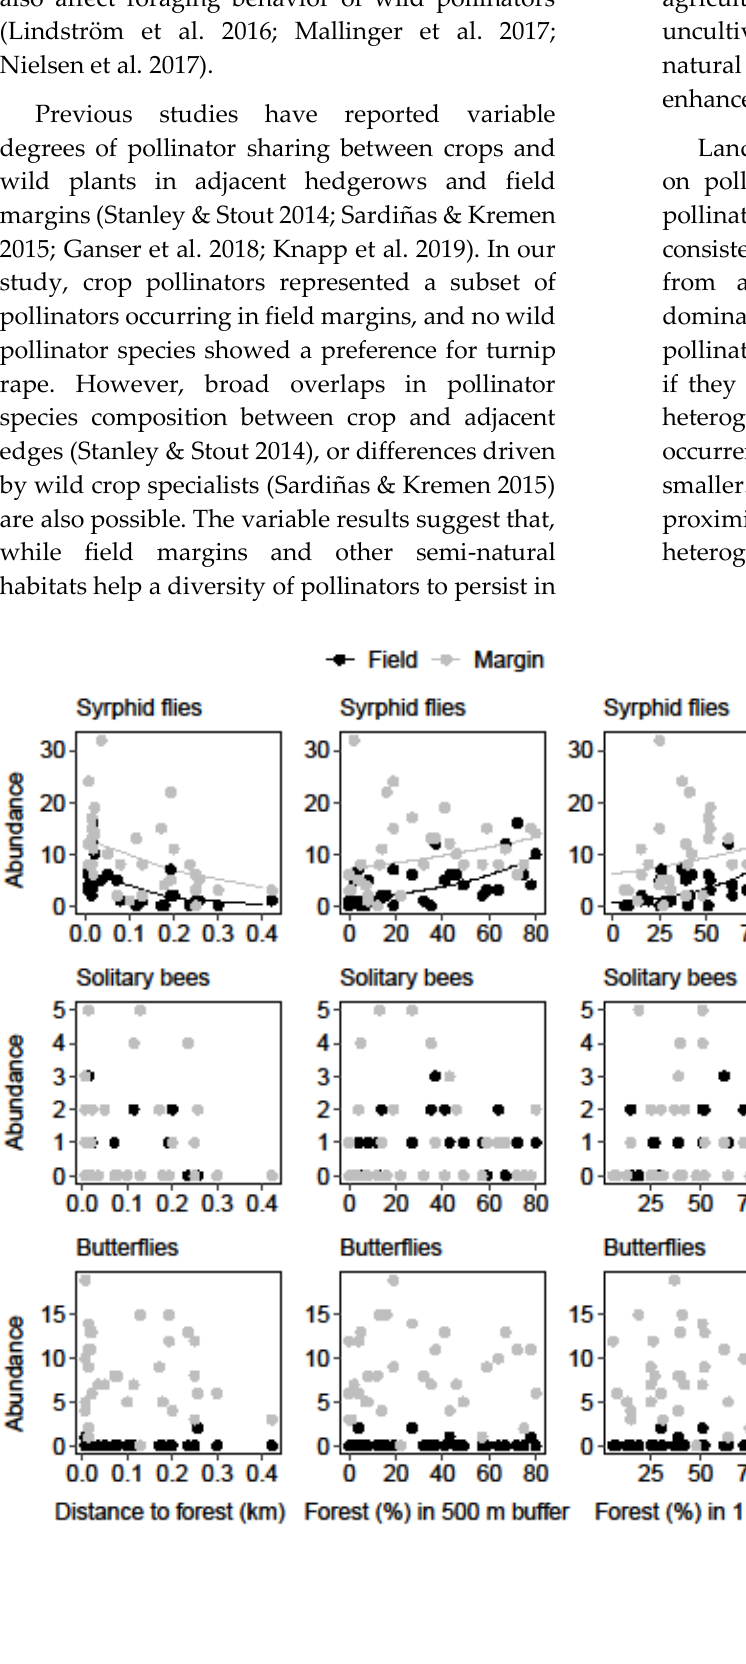
Lines in the scatterplots depict predicted values based on generalised linear mixed models with statistically significant interaction between habitat type and landscape heterogeneity (Tab. 2). Due to different pollinator observation methods, species